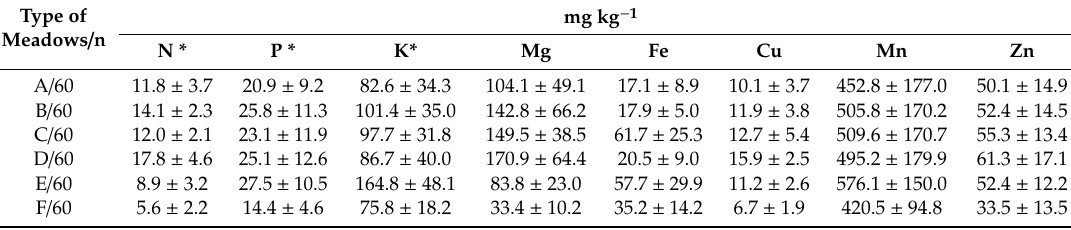
Table 2. Macro- and micro mineral concentrations in soil (mean ± SD).